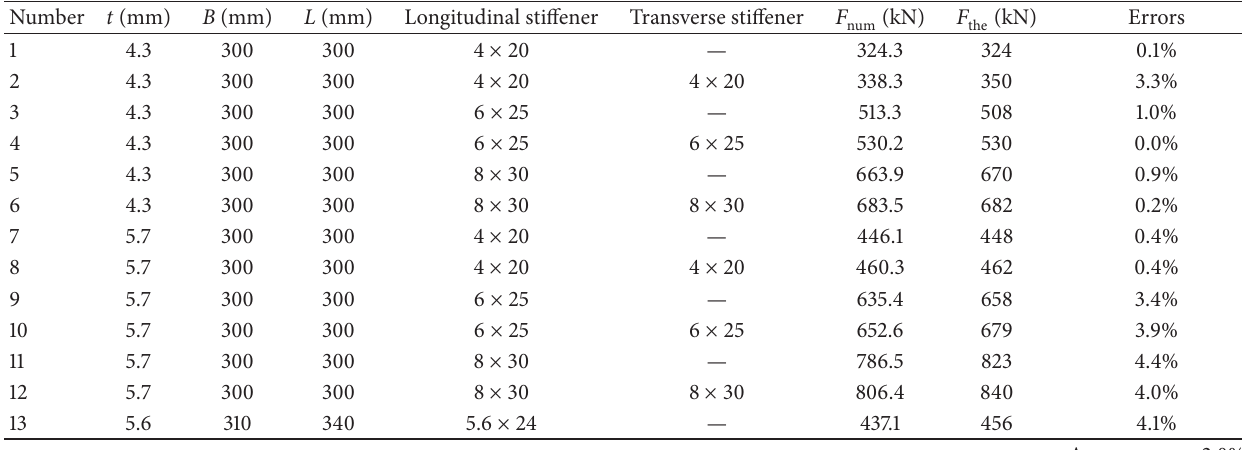
Table 6: Comparison of the field capacities derived from the theoretical and numerical